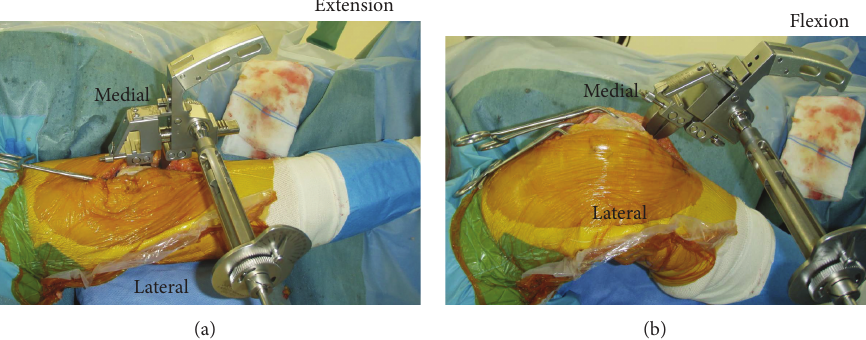
Figure 1: Measurements of intraoperative gap balance for the right knee at 0 ∘ (extension) and 90 ∘ (flexion) with the patella in a reduced position and a constant 40-pound distracting force being applied between the cut surfaces of the distal femur and the proximal tibia.